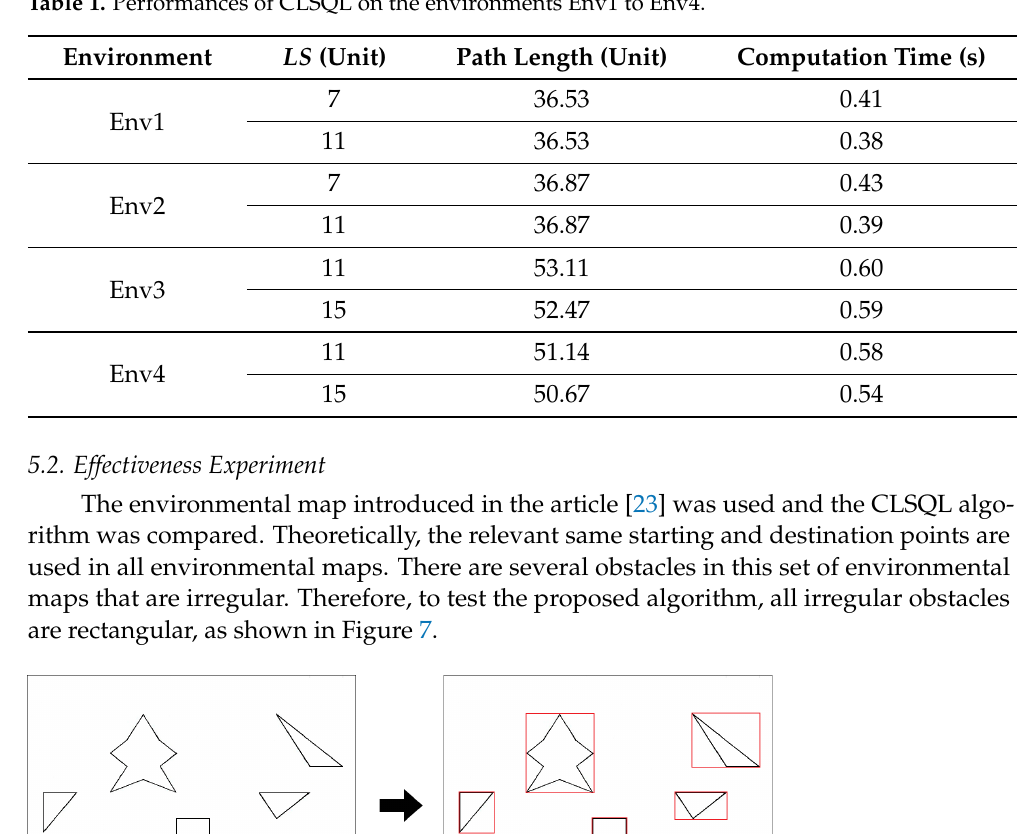
Table 1. Performances of CLSQL on the environments Env1 to Env4.